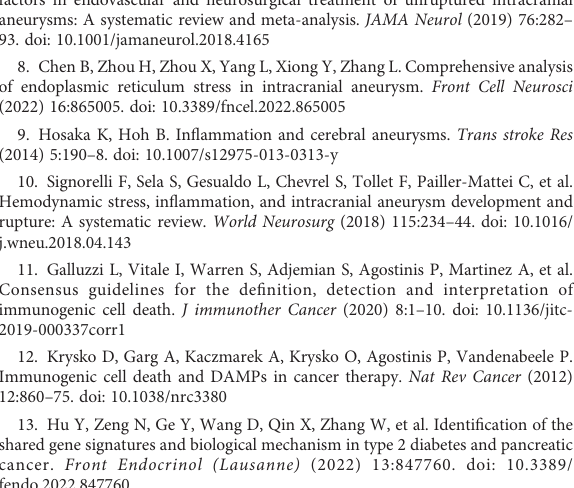
SUPPLEMENTARY FIGURE 2 DEGs in external validation dataset.